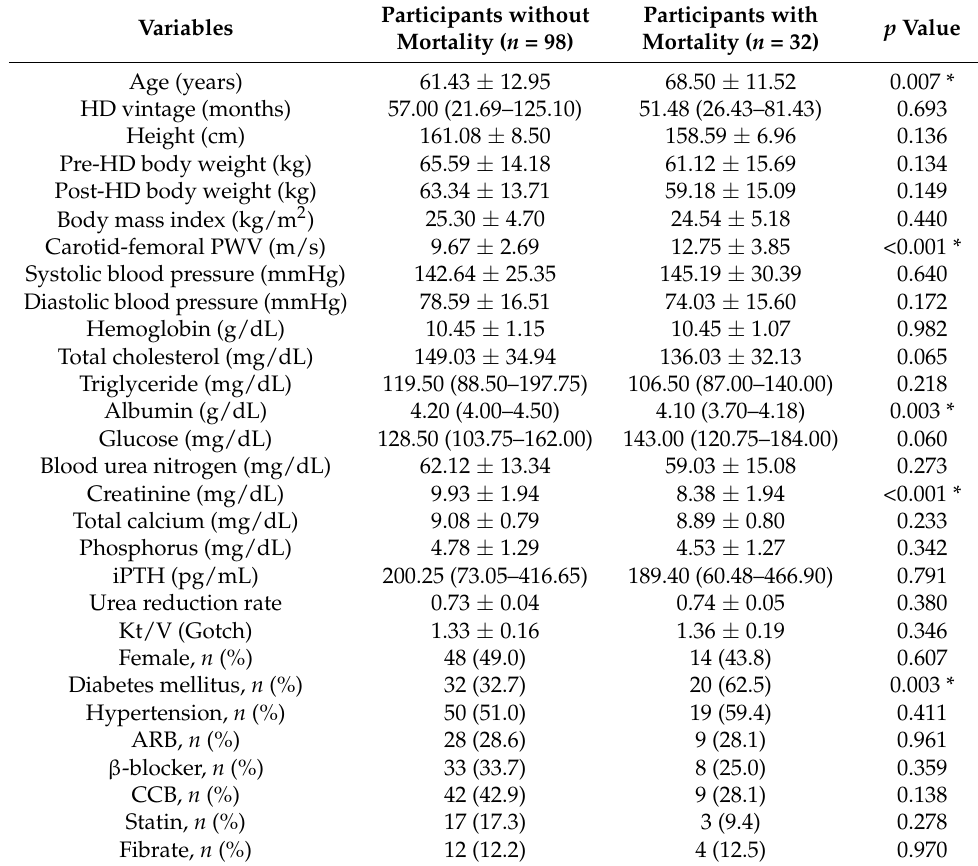
Table 2. Clinical variables of the 130 hemodialysis patients with or without mortality.